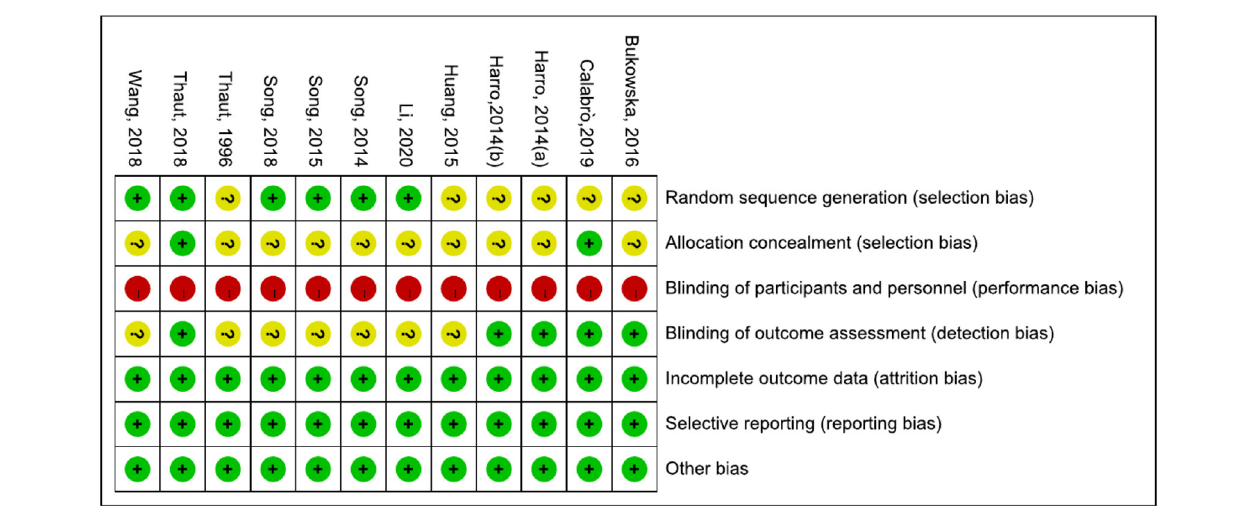
FIGURE 3 | Risk of bias